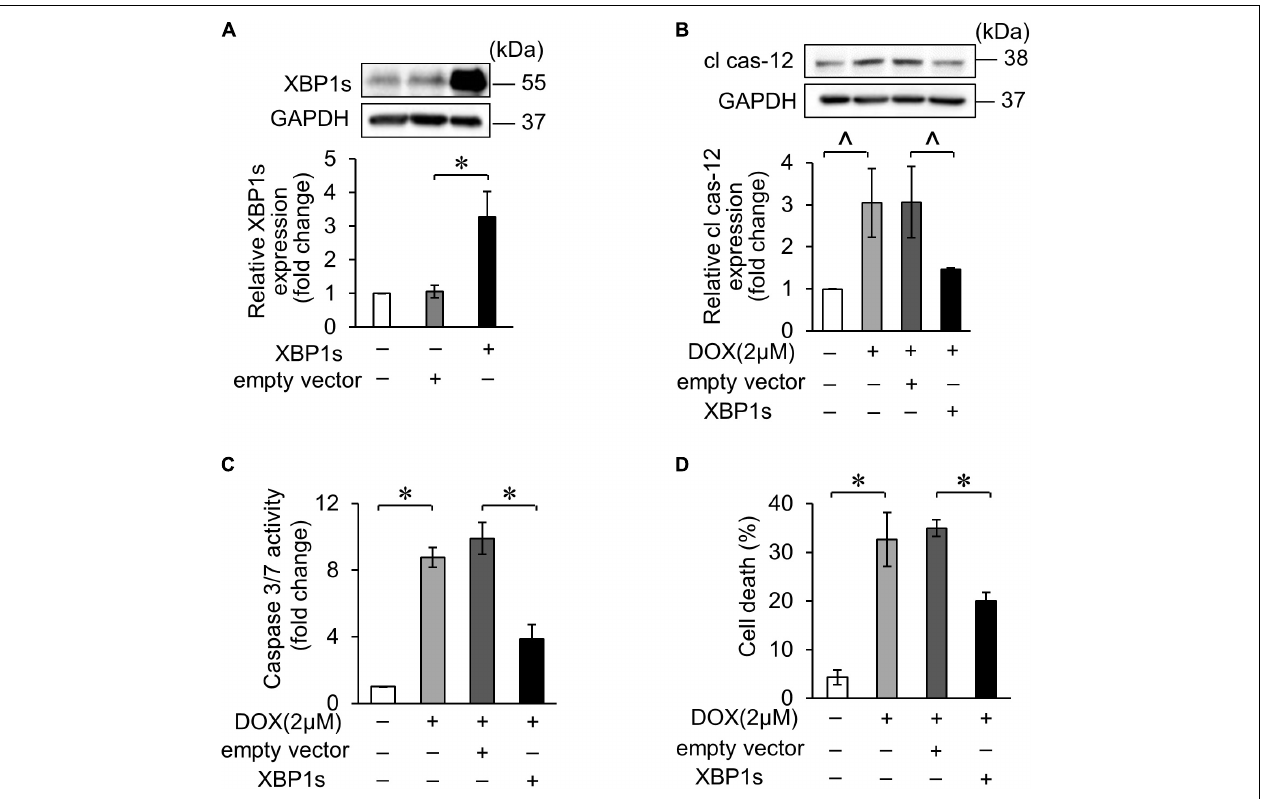
FIGURE 5 | XBP1s attenuated DOX-induced cardiomyocyte endoplasmic reticulum (ER) stress and apoptosis. (A) H9c2 was transfected with XBP1s-overexpressing plasmid for 24 h. The expression levels of XBP1s were determined using Western blot and the quantitative histogram was shown. (B–D) Enhanced XBP1s expression in H9c2 cells with XBP1s-overexpressing plasmid for 24 h and exposed to 2 µ M DOX for 24 h. The expression levels of cleaved caspase-12 were determined using Western blot and the quantitative histogram was shown (B) . Caspase-3/7 activity (C) and cell death rate (D) were analyzed.